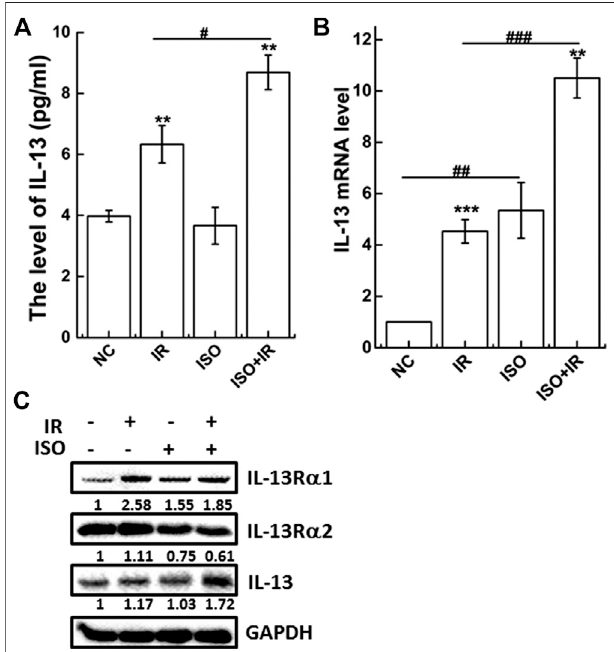
FIGURE4| ISOenhancesthelevelsofanti-in fl ammatoryIL-13activated by IR in A549 cells. The level of IL-13 (A) in supernatant of cells pretreated with/without ISO for 24 h, exposed to 2 Gy X-rays, and then detected 12 h after irradiation by MSD assay. The expression of IL-13 gene (B) and associated receptor proteins (C) were analyzed at 12 h after irradiation by qRT-PCRandwesternblot,respectively,inA549cellspretreatedwith/without ISO for 24 h and then exposed to 2 Gy X-rays. Fold changes over negative controlwerepresentedfrom2 − ΔΔ Ct formula.* p < 0.05,** p < 0.01,*** p < 0.001 vs. the control group. # p < 0.05, ## p < 0.01, and ### p < 0.001 vs. non-drug- treated